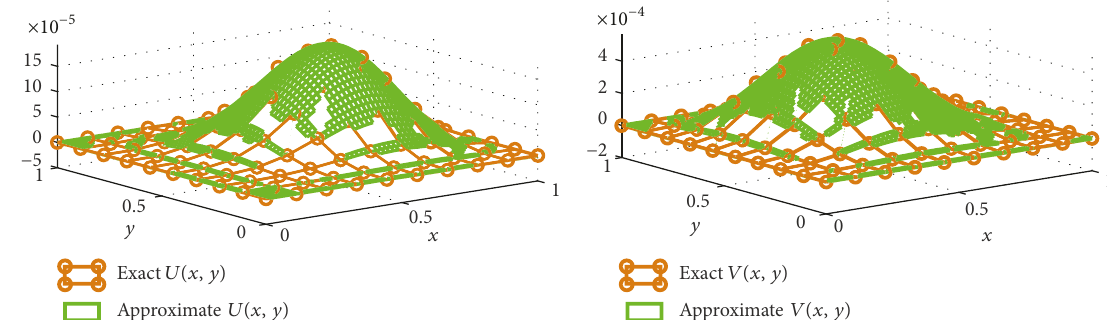
Figure 1: Evaluation of numerical and exact solutions 𝑈(𝑥,𝑦) , 𝑉(𝑥, 𝑦) corresponding to scale level 𝐾 = 10 of Problem 1.